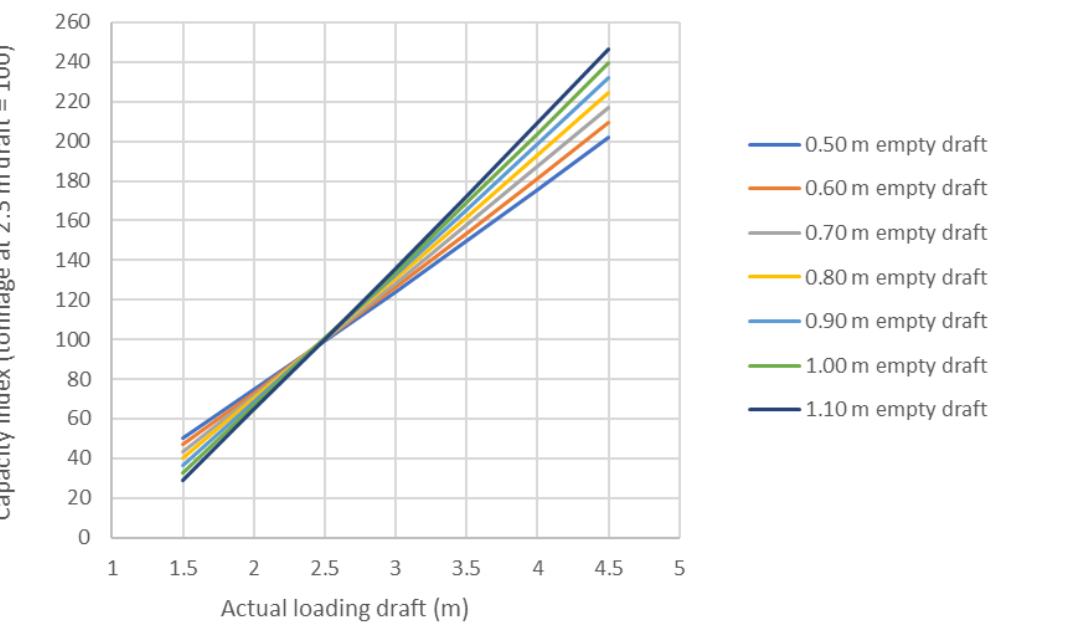
Figure 7. Capacity index for different empty and actual loaded